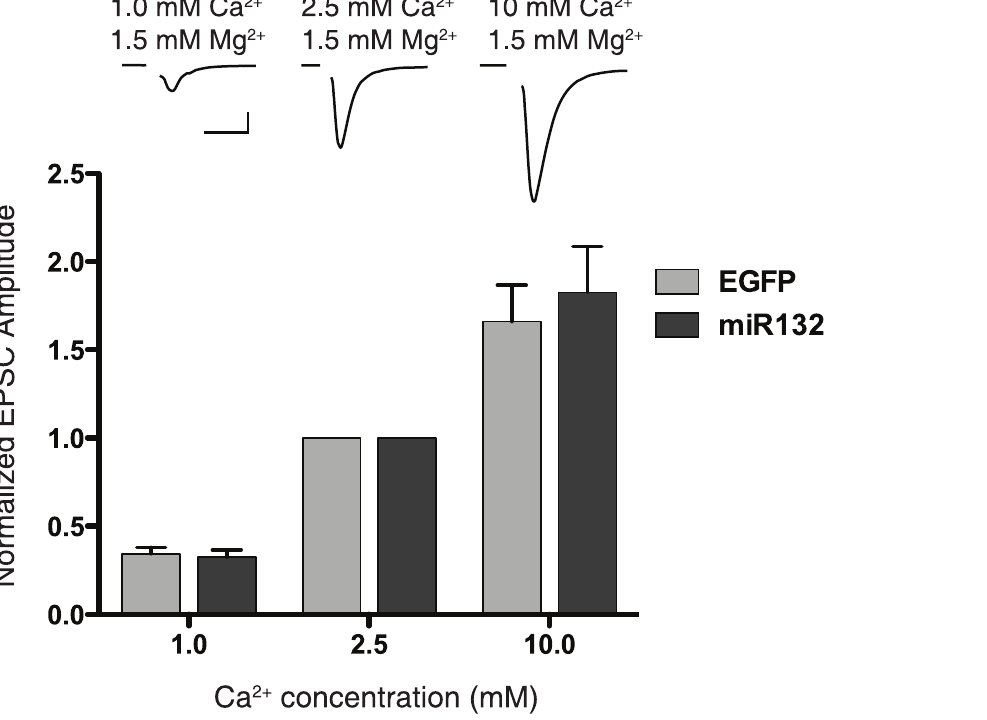
Figure 5. Calcium dependence of release is not altered by overexpression of miR132. External calcium was varied while extracellular magnesium concentration remained constant at 1.5 mM. EPSC peak amplitudes measured in 1 mM and 10 mM were normalized to the values measured in 2.5 mM calcium. miR132 overexpression had no significant effect on the calcium dependence of release (for all groups, n =9, t-test for 1 mM and 10 mM P . 0.05; scale bar for representative traces: 1nA, 10 ms).